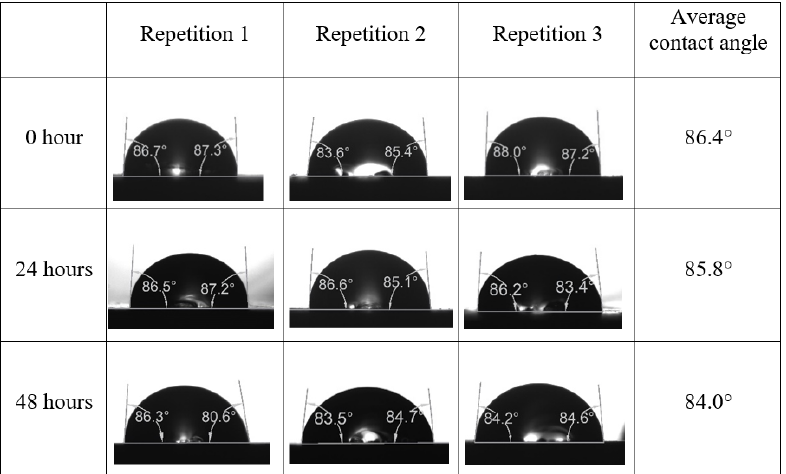
Figure A11. Dynamic Contact Angle Measurement Results for 75% MgCl 2 + 25% NaCl (3500